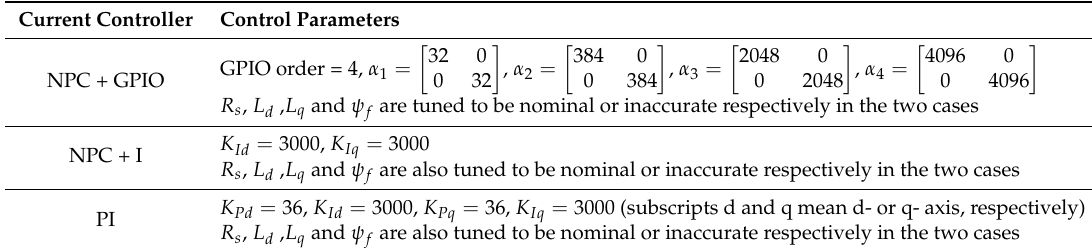
Table 2. Parameters of the three current controllers.